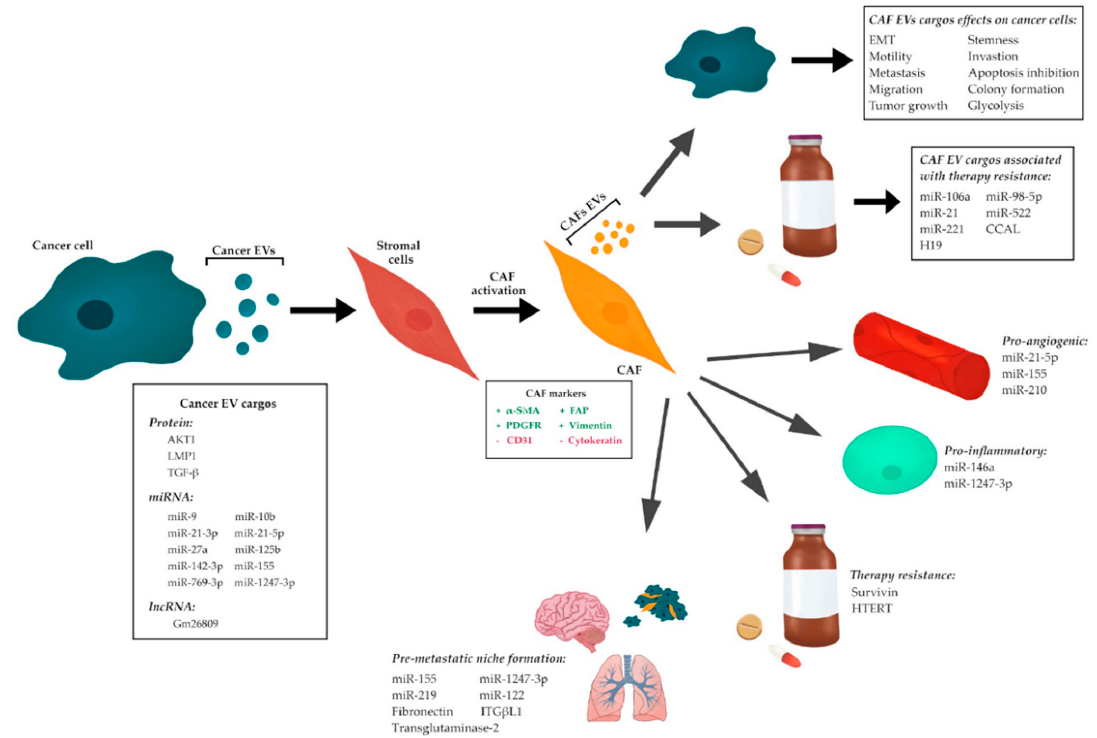
Figure 2. Summary of the extra-cellular vesicle (EVs)-mediated cross-talk between cancer cells and cancer-associated fibroblasts (CAFs). Cancer cells can influence stromal cells to activate a CAF phenotype through the release of EVs, which carry several cargos, including proteins, micro-RNAs (miRNA), and long noncoding-RNA (lncRNA). Specific cancer cells-derived EV cargos can also influence a pro-angiogenic or pro-inflammatory phenotype in CAF, and the induction of therapy resistance and pre-metastatic niche formation. At the same time, CAF-derived EVs cargos can influence cancer cells to increase epithelial-to-mesenchymal transition (EMT), growth, invasion, metastasis, motility, stemness, colony formation, apoptosis inhibition, glycolysis, and therapy resistance.